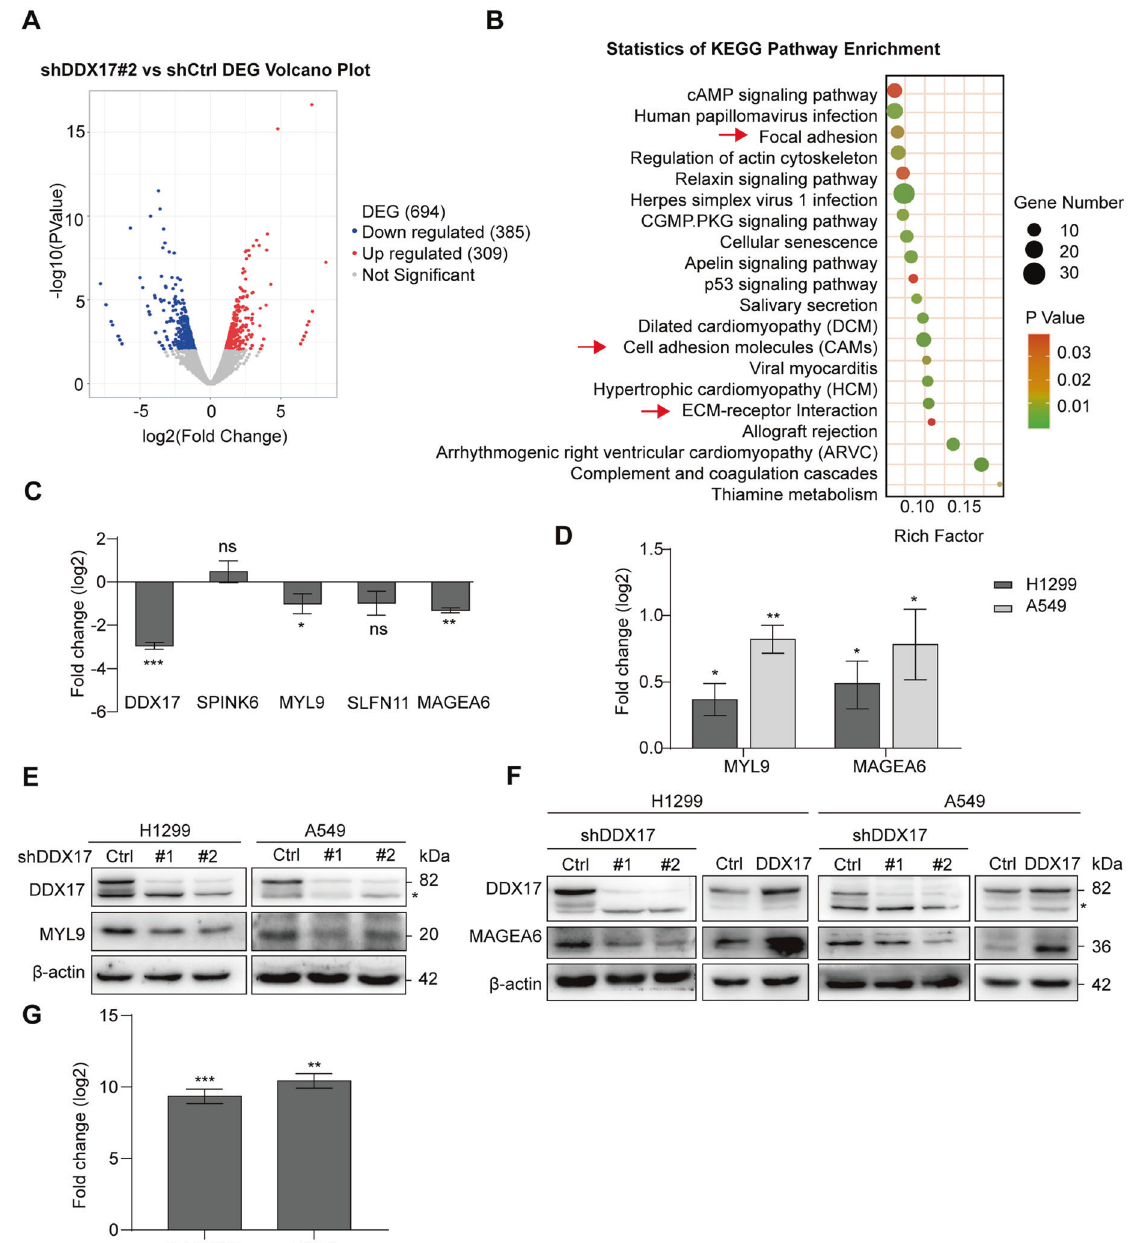
Fig. 3 DDX17 regulates the mRNA and protein levels of MYL9 and MAGEA6. A Volcano plot of global DEGs between H1299-shDDX17#2 cells and their corresponding control cells. B the functions of DEGs were predicted by analysis of KEGG by DAVID (https://david.ncifcrf.gov/). C The log2 transformation of the fold-change of the relative mRNA expression levels in the 4 DEGs selected for qRT-PCR in DDX17 silencing or control cells. D mRNA level of MYL9 and MAGEA6 in H1299 and A549 cells transiently transfected with Flag-DDX17 plasmids or Flag-vector. E , F DDX17 and MAGEA6 expression in the indicated cells assessed by western blotting. β -actin was used as loading control. G The relative abundance of MYL9 and MAGEA6 mRNA present in the DDX17-IP assay by qRT-PCR. Data are presented as mean ± s.e.m. ( C , D , G ). *p < 0.05, **p < 0.01, ***p < 0.001, determined by two-tailed Student ’ s t -tests.